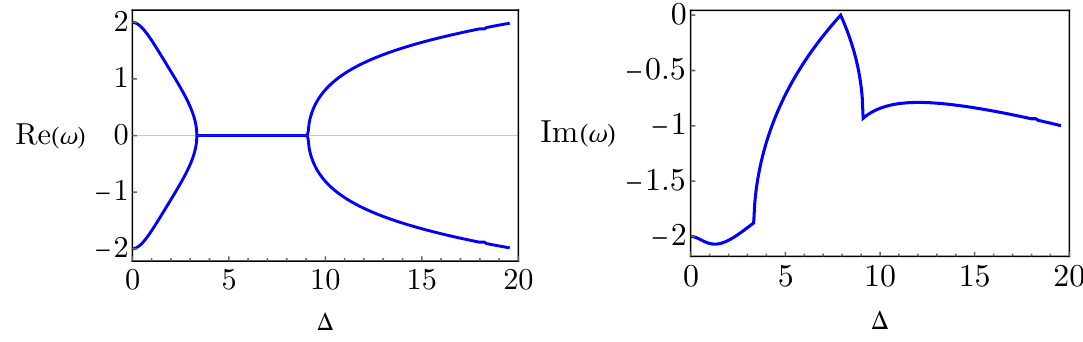
Figure 3 . Real and imaginary part of the frequency of the lowest lying QNM as a function of the parameter